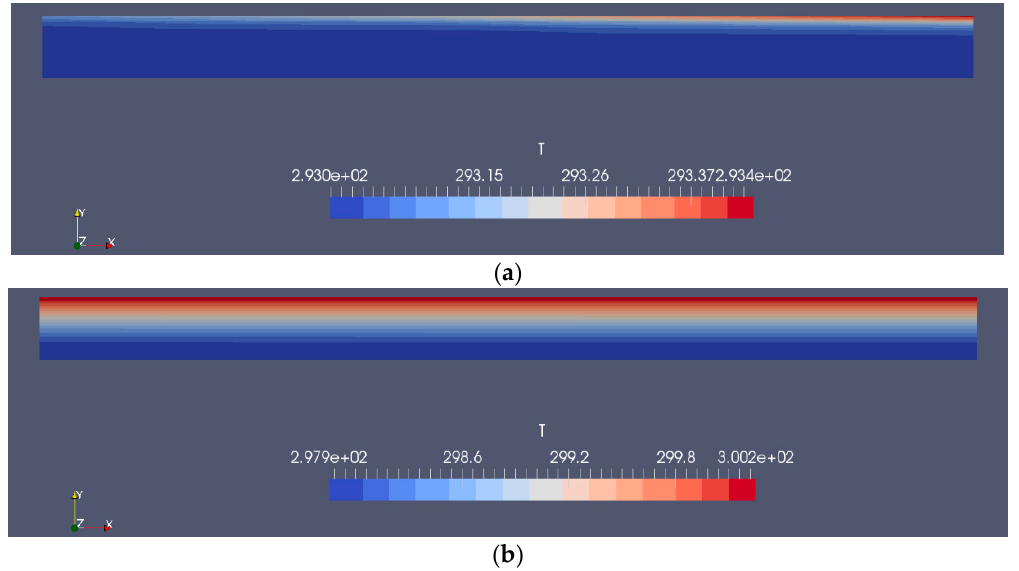
Figure 6. The computed temperature distribution (expressed in K) for laminar flow of water at Re = 965: ( a ) Inlet part of the pipe; ( b ) Outlet part of the pipe.